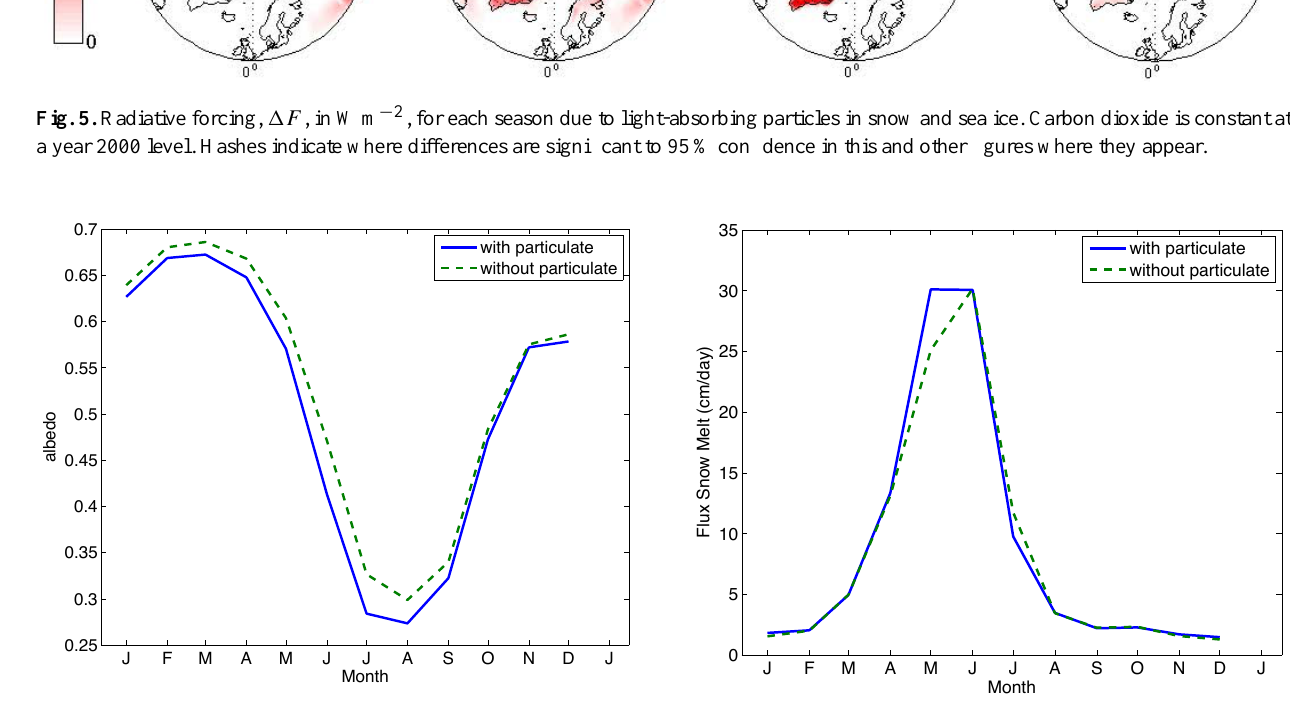
Fig. 7. The seasonal cycle of snow melt rate (cmday − 1 ) North of 60 ◦ N, both with and without the surface particulate impurity forc- ing